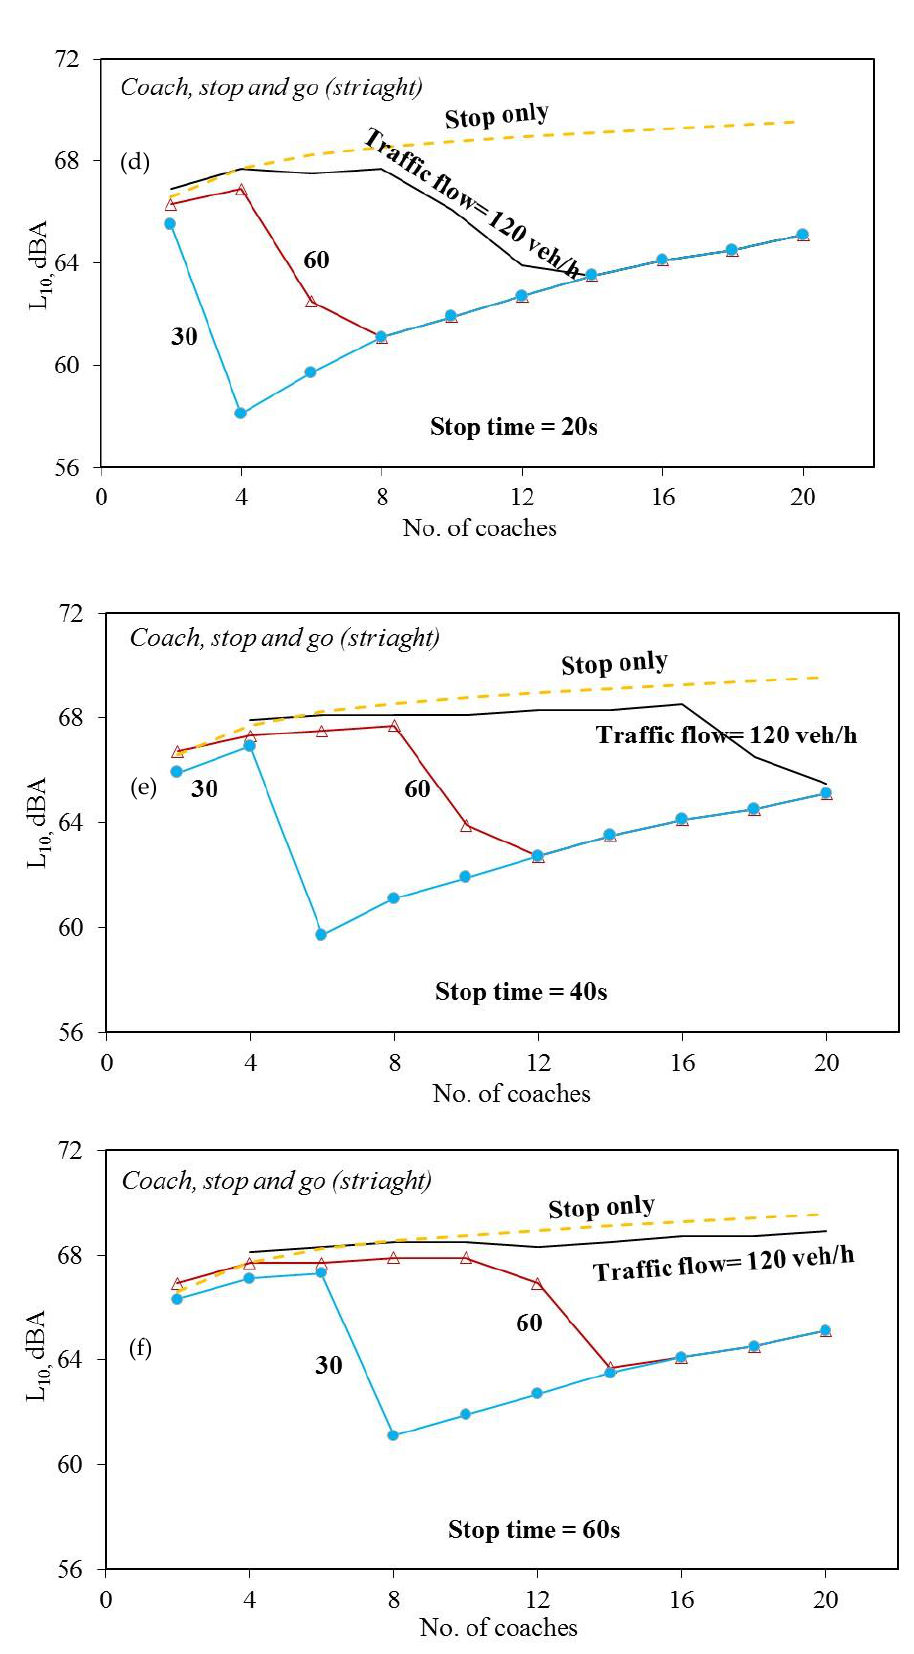
Figure 9. A comparison of average sound pressure levels ( L 10 ) passing through the measurement points for various traffic flows. ( a ) Van, stop time = 20s; ( b ) Van, stop time = 40s; ( c ) Van, stop time = 60s; ( d ) Coach, stop time = 20s; ( e ) Coach, stop time = 40s; ( f ) Coach, stop time = 60s.